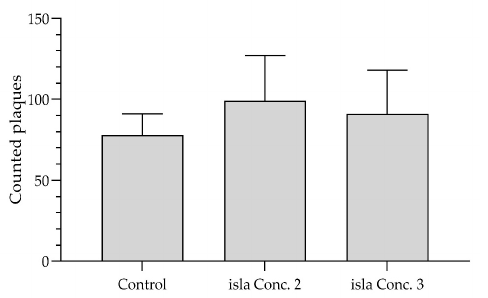
Figure11. Modifiedplaqueassay—Influenceofthehydrogelsisla ® medicConc. 2(0.115glozenge / mL)and Figure 11. Modified plaque assay—Influence of the hydrogels isla ® medic Conc. 2 (0.115 g lozenge/mL) and Conc. 3 (0.077 g lozenge/mL) on plaque formation on H1-HeLa cells. Counted Conc. 3 (0.077 g lozenge / mL) on plaque formation on H1-HeLa cells. Counted plaques, mean ± standard plaques, mean ± standard deviation of three measurements with three repetitions. deviation of three measurements with three